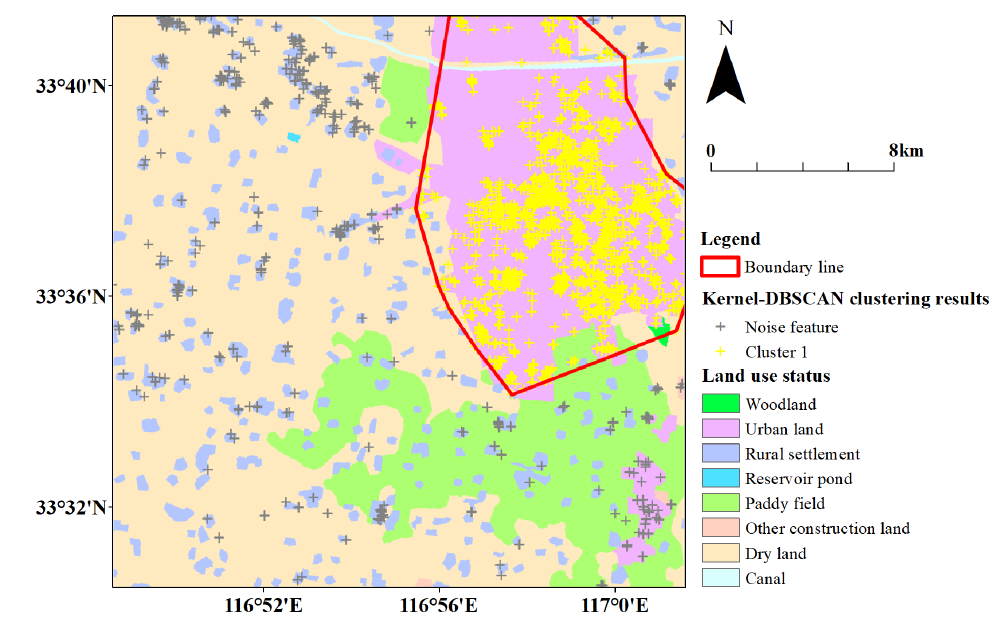
Figure 15. The boundary of areas with dense artificial buildings.